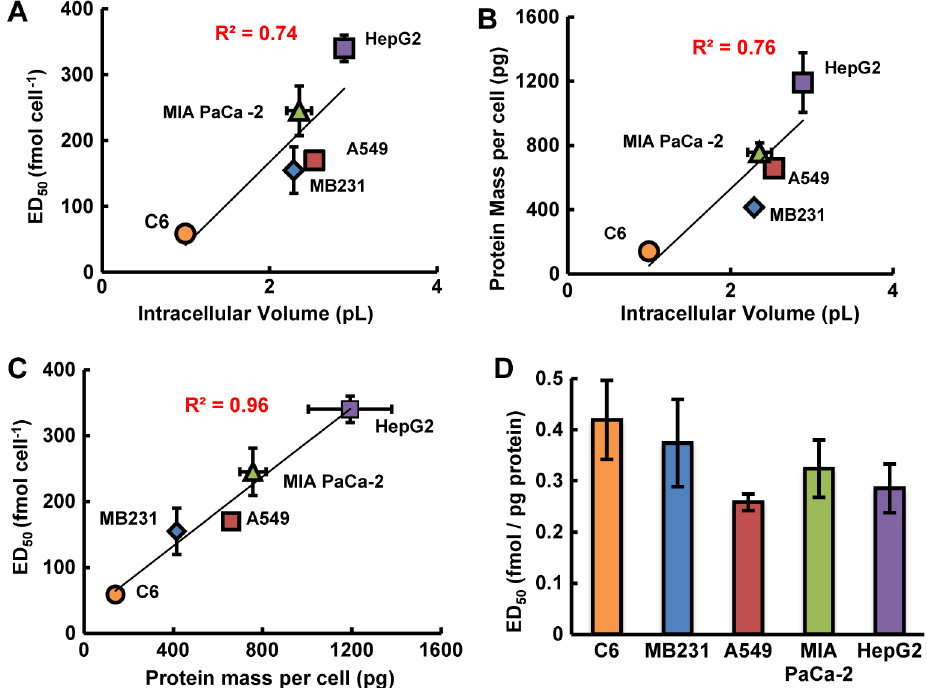
Fig 7. ED 50 of 1,4-BQ correlates directly with intracellular volume and mass of protein per cell for C6, MB231, A549, MIA PaCa-2, and HepG2 cell lines. (A) The dose of 1,4-BQ (mol cell -1 ) at which 50% clonogenic survival was observed for each cell type is plotted vs. the measured intracellular volume (Table 1). The correlation coefficient R 2 is 0.74. Each cell line has n = 2 for biological replicates, n = 3 within each replicate. The measured intracellular volume represented is the mean of two different methods of measuring intracellular volume. Each cell line was measured ( n = 3) using a Z2 Coulter Counter and a Moxi Z Mini Automated Cell Counter in ISOTON II Diluent (Beckman Coulter, Inc.). Error bars represent the standard error of the mean; some error bars are smaller than the symbol. (B) Mass of protein per cell directly correlates with intracellular volume (R 2 = 0.76). Protein content was measured in the five cell lines used (C6, MDA-MB231, A549, MIA PaCa-2, and HepG2) by the SDS-Lowry protein assay. Some of the uncertainties in protein mass per cell are smaller than the symbols. Error bars represent the standard error of the mean. Each protein measurement has n = 3 for biological replicates, n = 3 within each replicate. (C) The ED 50 of 1,4-BQ for C6, MB231, A549, MIA PaCa-2, and HepG2 cells (mol cell -1 ) is plotted vs. measured protein mass (pg) per cell. The correlation coefficient R 2 is 0.96. Error bars represent the standard error of the mean. (D) The ED 50 of 1,4-benzoquinone is expressed as fmol of 1,4-benzoquinone per pg protein for a cell. Each protein measurement has n = 3 for biological replicates, n = 3 within each replicate. Error bars represent the propagation of error as determined from the standard error of the means for both protein measurements and ED 50 of 1,4-BQ. When dose of 1,4-BQ is expressed as fmol pg -1 , there was no statistical difference in the ED 50 of 1,4-BQ observed across the different cell lines. ANOVA showed p > 0.05 for all